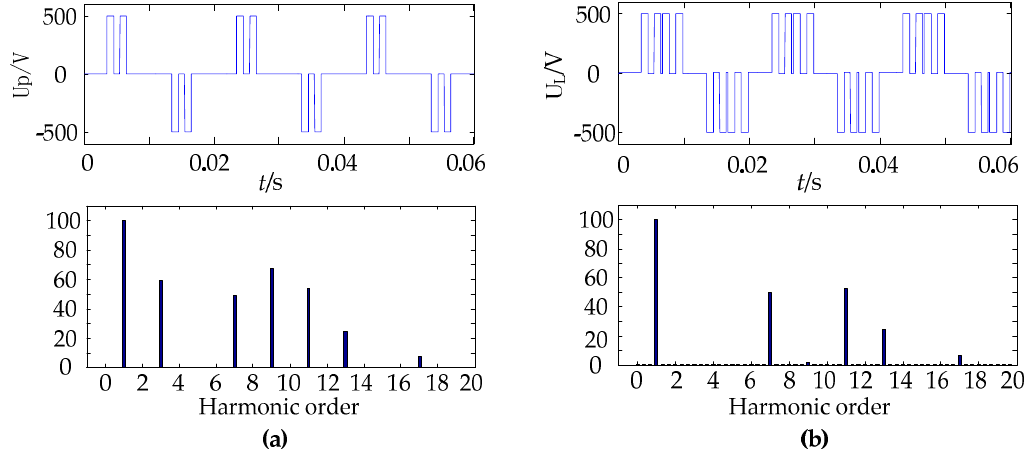
Figure 7. Simulation results with a modulation index of 0.2: ( a ) waveforms of phase voltage and its spectrum analysis; ( b ) waveforms of line voltage and its spectrum analysis.